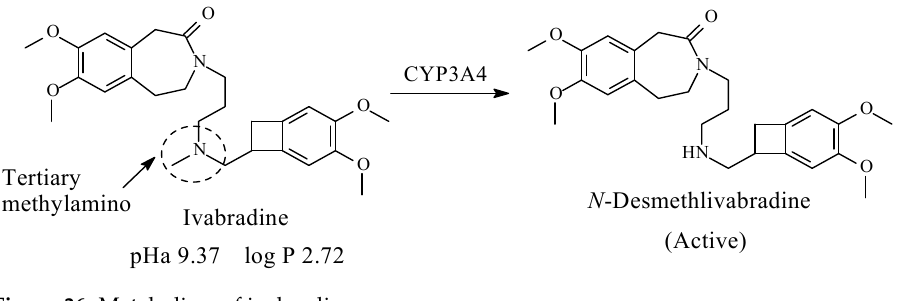
2 Figure 35. Metabolic pathways of oxybutynin.